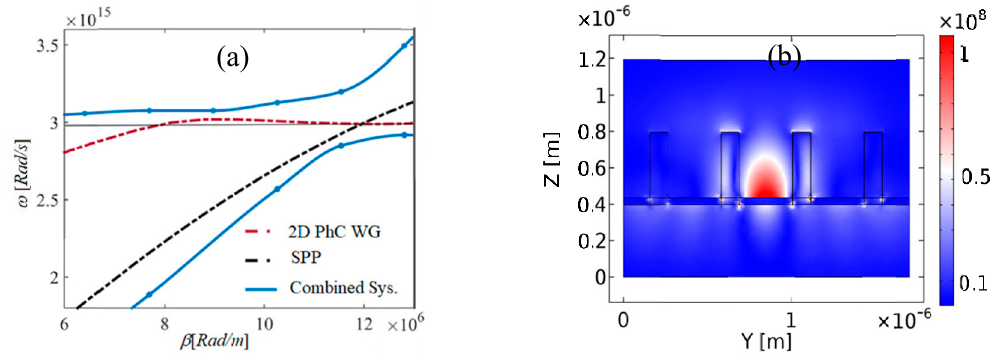
Figure 5. ( a ) Dispersion diagram of a 22D PhC waveguide with r/a = 0.22 and the SPP modes of the tri-layer (shown in Figure 4) together with the dispersion diagram of the combined syst e m (shown